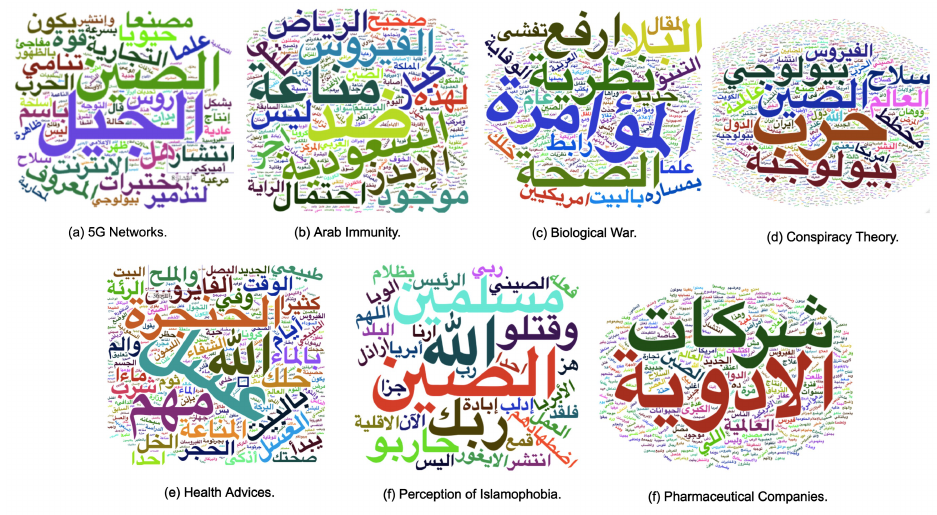
Figure 2. Word clouds for different types of misinformation.